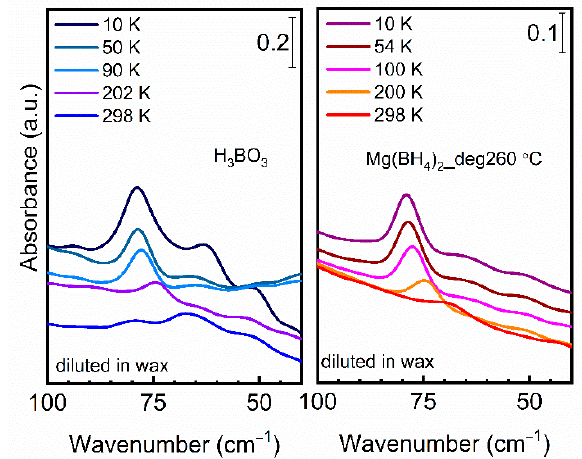
Figure 4. Temperature dependence of the far-IR spectra in the R T -10 K for the reference H 3 BO 3 ( left ) and the Mg(BH 4 ) 2 decomposed at 260 °C ( right ).